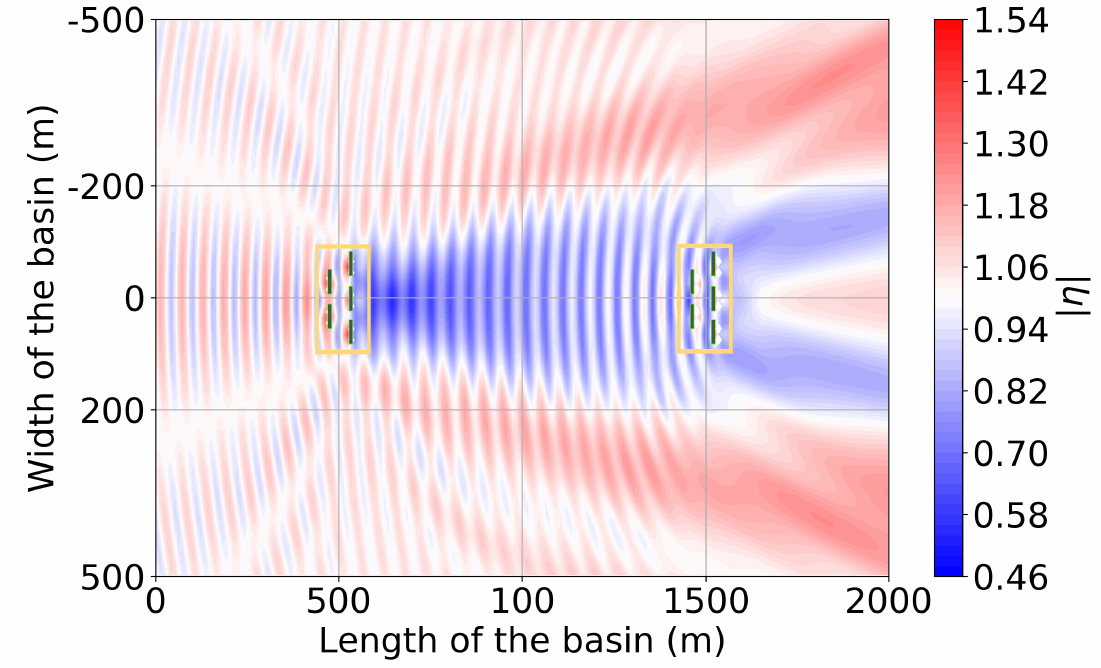
Figure 11. Coupled | η | for H = 2.0 T = 10.0 s and β = 0 ◦ regular wave for a 10 WEC 2-Array farm over a sloping bathymetry shown in Figure